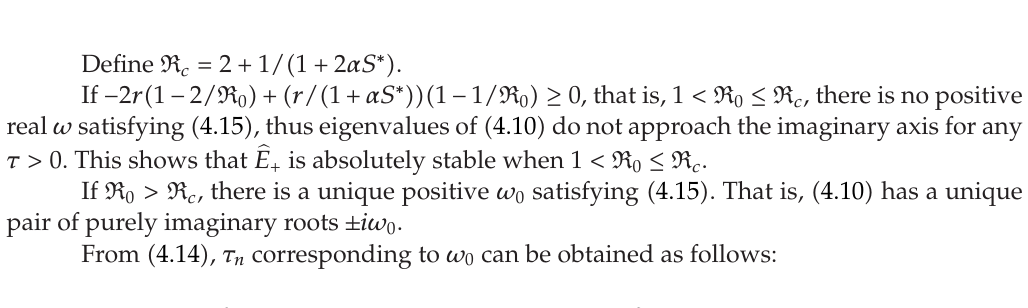
a absolutely stable b conditionally